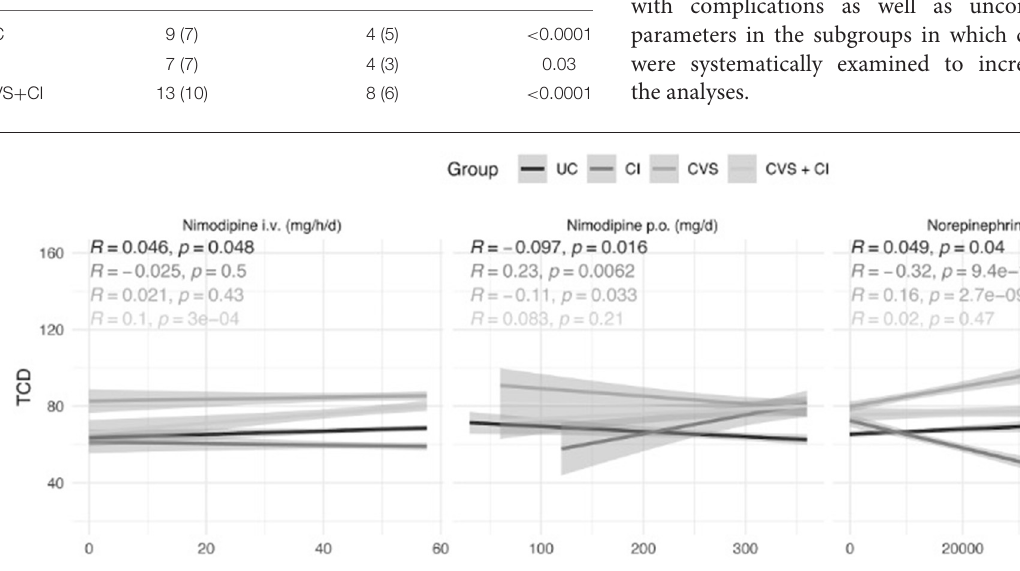
Frontiers in Neurology |